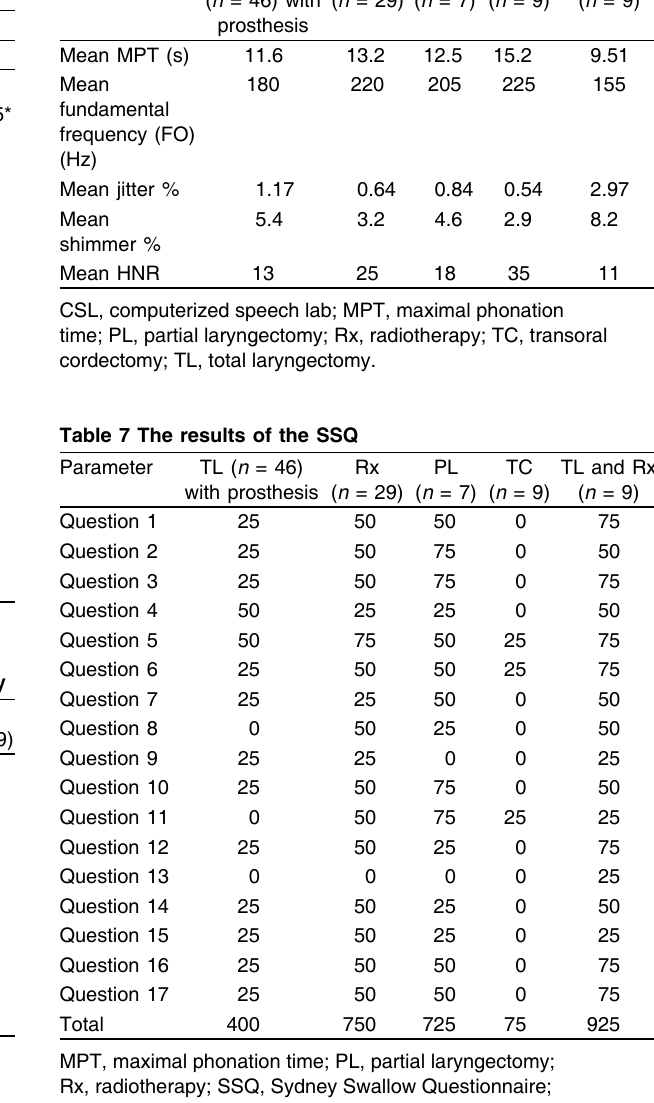
Table 4 Univariate and multivariate analysis of prognostic covariates for a better post-treatment global quality of life